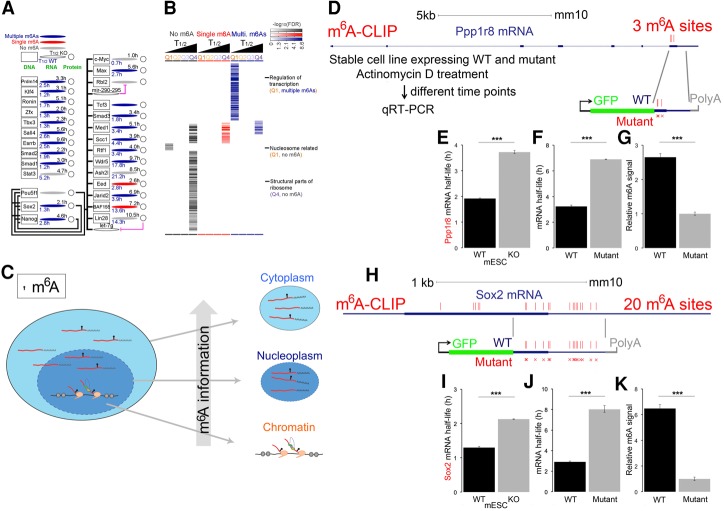
mRNAs with or without m6As are associated with important biological functions, and minigene mutational validation for m6A specifies mRNA turnover. (A) Most mRNAs of key genes controlling the ESC state (data modified from Young 2011; the detailed transcriptional regulation information and connection between terms are described fully in Young 2011) have multiple m6A peaks. mRNAs are symbolized as ellipse shapes. (Gray) No m6A; (red) single m6A; (dark blue) multiple m6A peaks; (T1/2 WT) the mRNA T1/2 in wild-type mouse ESCs; (T1/2 KO) the mRNA T1/2 in mouse ESCs with Mettl3 knockout (details in Fig. 6). The thick black lines connecting genes symbolize transcriptional regulation. (B) GO analysis of 12 groups of mRNAs (12 = 3 × 4: combinations of four T1/2 groups [Q1, Q2, Q3, and Q4] and three m6A groups [no m6A, single m6A, or multiple m6A peaks per mRNA]). The values of −log10(FDR) are illustrated as a heat map. None of mRNA groups in Q2 and Q3 T1/2 groups showed enrichment in any GOs. A specific GO example was provided for each of the three mRNAs groups: Q1 and multiple m6As, Q1 and no m6A, and Q4 and no m6A. (C) The m6A information flow from chromatin, nucleoplasm, and cytoplasm as an important implication. It is based on the fact that m6A modification is the same in the newly formed pre-mRNA as in the nucleoplasmic and steady-state cytoplasmic mRNAs (Fig. 2A,B). (D) Illustration of the minigene experiment, using Ppp1r8 as an example. The CDS of Ppp1r8 mRNA contains three precise m6A sites identified by m6A-CLIP (three vertical lines). This m6A-containing region was cloned to a minigene vector in-frame with GFP. Three synonymous point mutations (three red crosses) abolished the three precise m6A sites without altering the underlying amino acid sequence (detailed sequences for both the wild type and mutant are in the Supplemental Material). (E) Upon global loss of m6A in Mettl3 knockout mouse ESCs, which completely abolished the m6A peaks in Ppp1r8 mRNA, the mRNA T1/2 increased from 2 to 3.8 h. (***) P < 0.001, t-test. (F) Three synonymous mutations in the minigene increase the minigene mRNA T1/2 from ∼3 to ∼7 h. (***) P < 0.001, t-test. (G) Three synonymous mutations in the minigene decreased m6A signal in wild-type mRNA to approximately one-third in knockout mRNA. (***) P < 0.001, t-test. (H) Illustration of the minigene experiment in Sox2. The CDS of Sox2 mRNA contains 20 precise m6A sites identified by m6A-CLIP (20 vertical lines). A mRNA region containing 15 precise m6A sites was cloned to a minigene vector in-frame with GFP. Fifteen point mutations (illustrated by 15 red crosses: four synonymous mutations in the coding region and 11 point mutations in the 3′ UTR that mutate the “A” in RAC motif to “T”) abolished the 15 precise m6A sites without altering the underlying amino acid sequence (detailed sequences for both the wild type and mutant are in the Supplemental Material). (I) Upon global loss of m6A in Mettl3 knockout mouse ESCs, which completely abolished the m6A peaks in Sox2 mRNA, the mRNA T1/2 increased from 1.3 to 2.2 h. (***) P < 0.001, t-test. (J) Point mutations in the minigene increase the minigene mRNA T1/2 from ∼3 to ∼8 h. (***) P < 0.001, t-test. (K) Point mutations in the minigene decreased m6A signal in wild-type mRNA to approximately one-sixth in knockout mRNA. (***) P < 0.001, t-test.